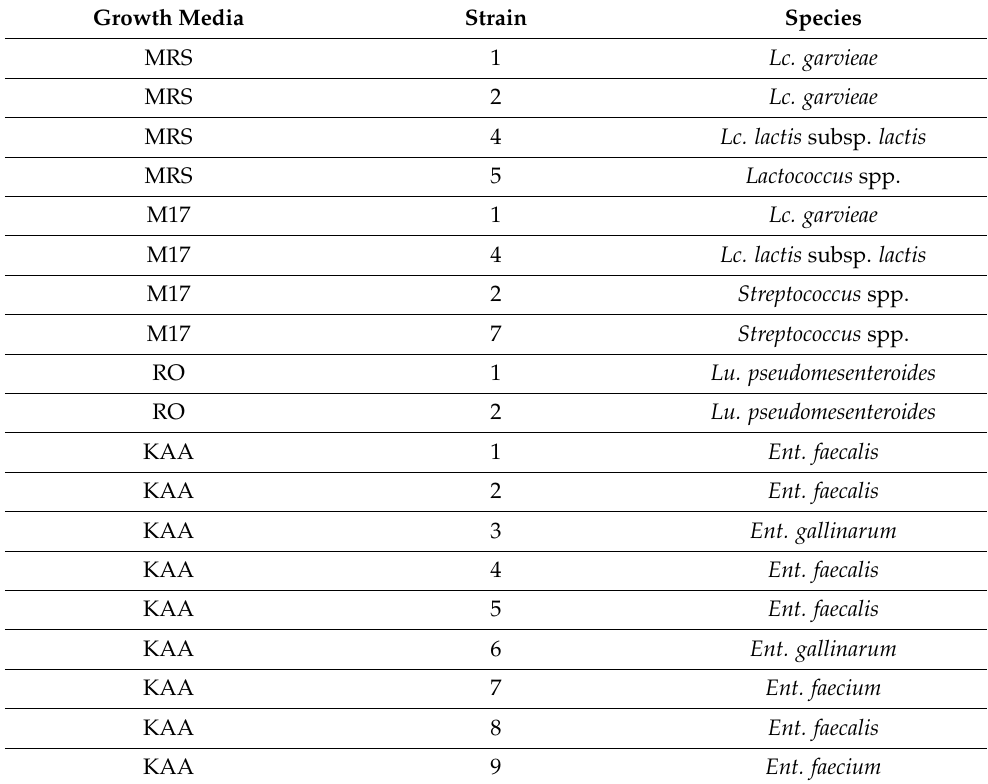
Table 2. Identification of isolated cocci using classical